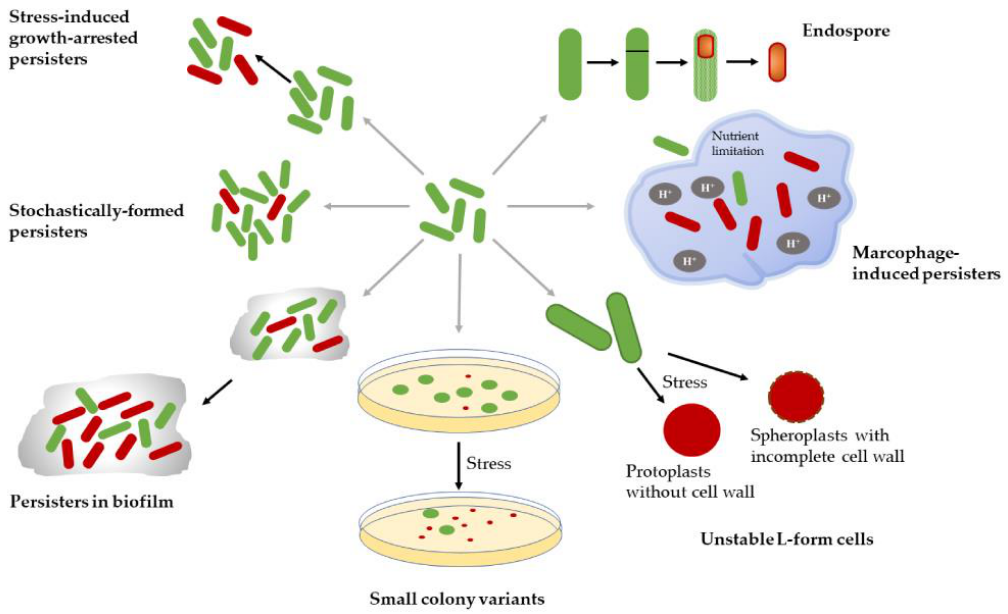
Figure 2. Di ff erent types of persister-cells and bacterial spores. Green images: susceptible bacteria cells. Figure 2. Different types of persister-cells and bacterial spores . Green images: susceptible bacteria Red images: persisters. Images are not drawn to cell s. Red images: persisters. Images are not drawn to scale.